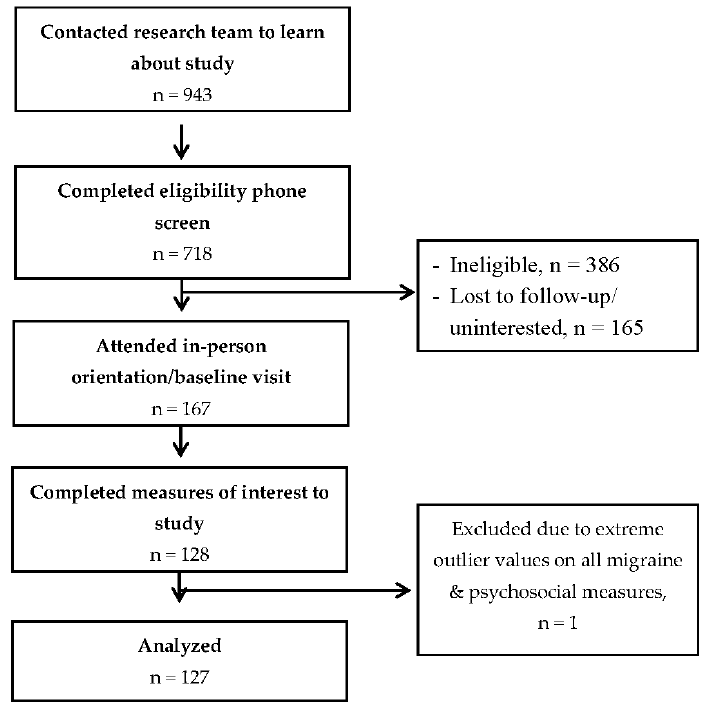
Figure 1. Study flow.